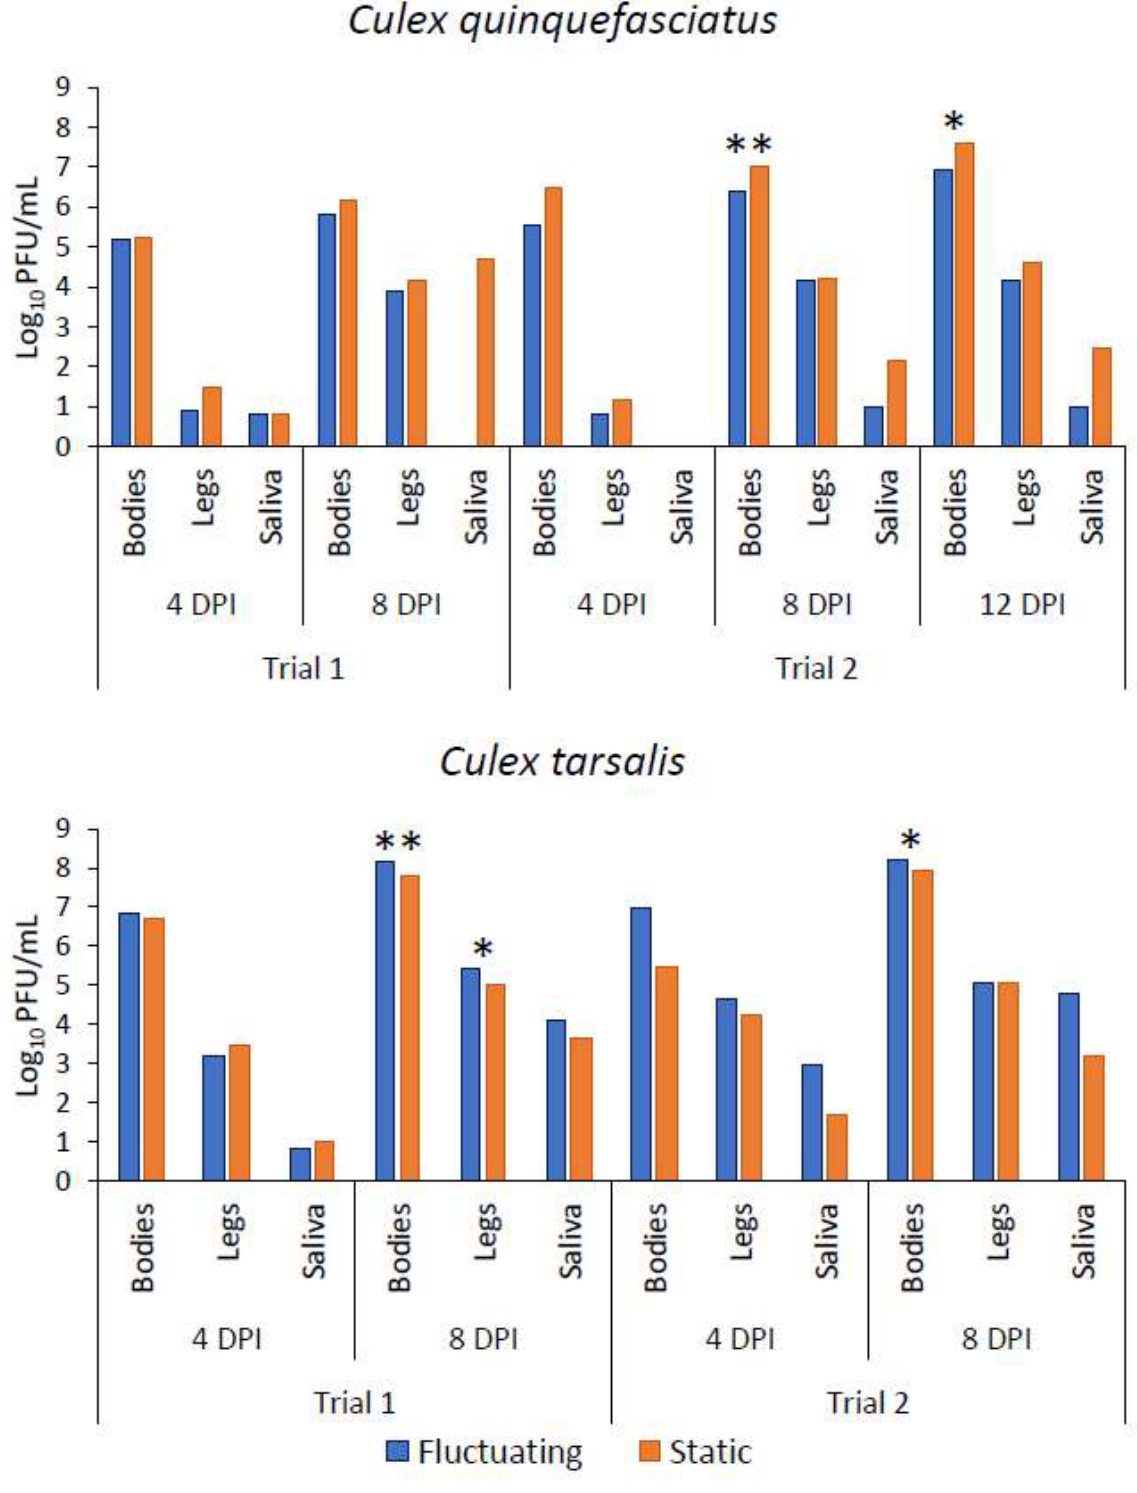
Figure 2. Mean viral titer in bodies, legs, and saliva of Cx. quinquefasciatus and Cx. tarsalis exposed to fluctuating and static temperature treatments at 11 ◦ C DTR (Trial 1) and 15 ◦ C DTR (Trial 2). Overall, Cx. quinquefasciatus had higher titers in static treatments in both trials while Cx. tarsalis had higher mean titers in fluctuating treatments. Asterisks denote significance at p = 0.05 (*) or p < 0.001